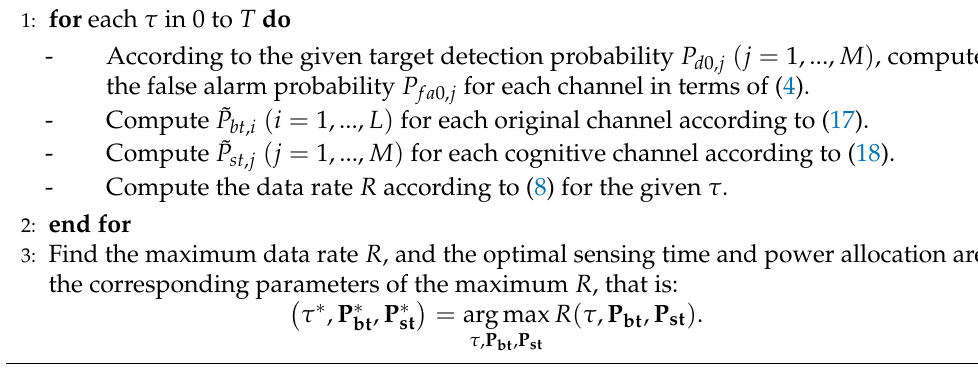
Algorithm 1 Optimal multiband spectrum sensing and power allocation method